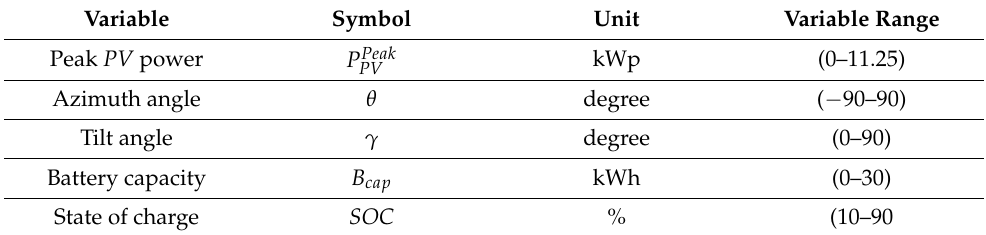
Table 3. System variables and their range.